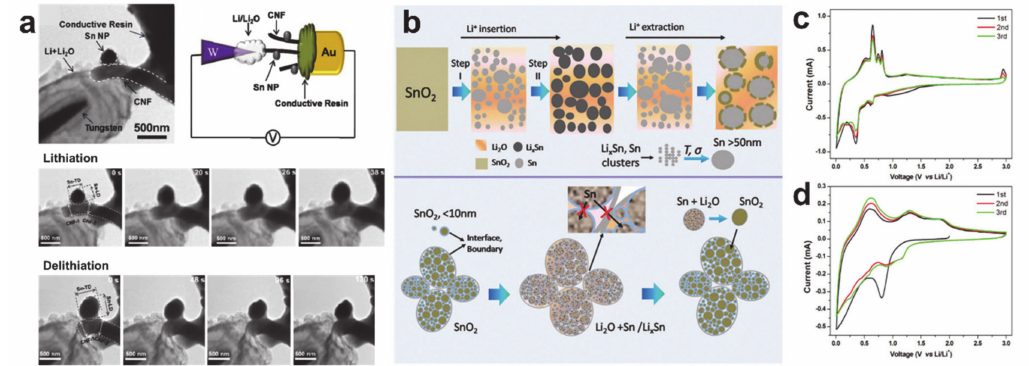
Figure13. ElectrochemicalbehaviorsofSnandSnO 2 . ( a )Real-timeobservationofSnalloying / dealloying behaviorusinginsitutransmissionelectronmicroscopy(reprintedwithpermissionfrom[176]; copyright 2015Elsevier), ( b )schematicillustrationsofmicrostructuralchangeofSnO 2 duringlithiation /